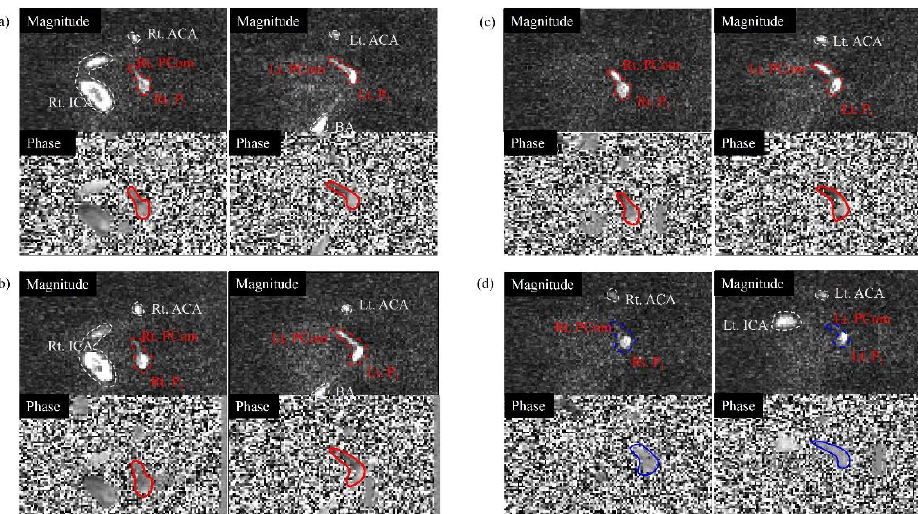
Figure 7. Representative slices for the analysis of the posterior communicating artery (Pcom) flow directions at VENC = 50 cm/s (magnitude and phase images on the top and bottom, respectively, and images of right and left vessels on the left and right, respectively): ( a ) normal phantom; ( b ) right ICA 50% stenosis phantom (ICA50); ( c ) right ICA 100% occlusion phantom (ICA100); and ( d ) right VA 100% occlusion phantom (VA100). The phase images were obtained from an anterior – posterior encoding direction. The red lines represent the normal flow of the Pcom, and the blue lines represent the reversed flow. The white dotted lines indicate the ICA.